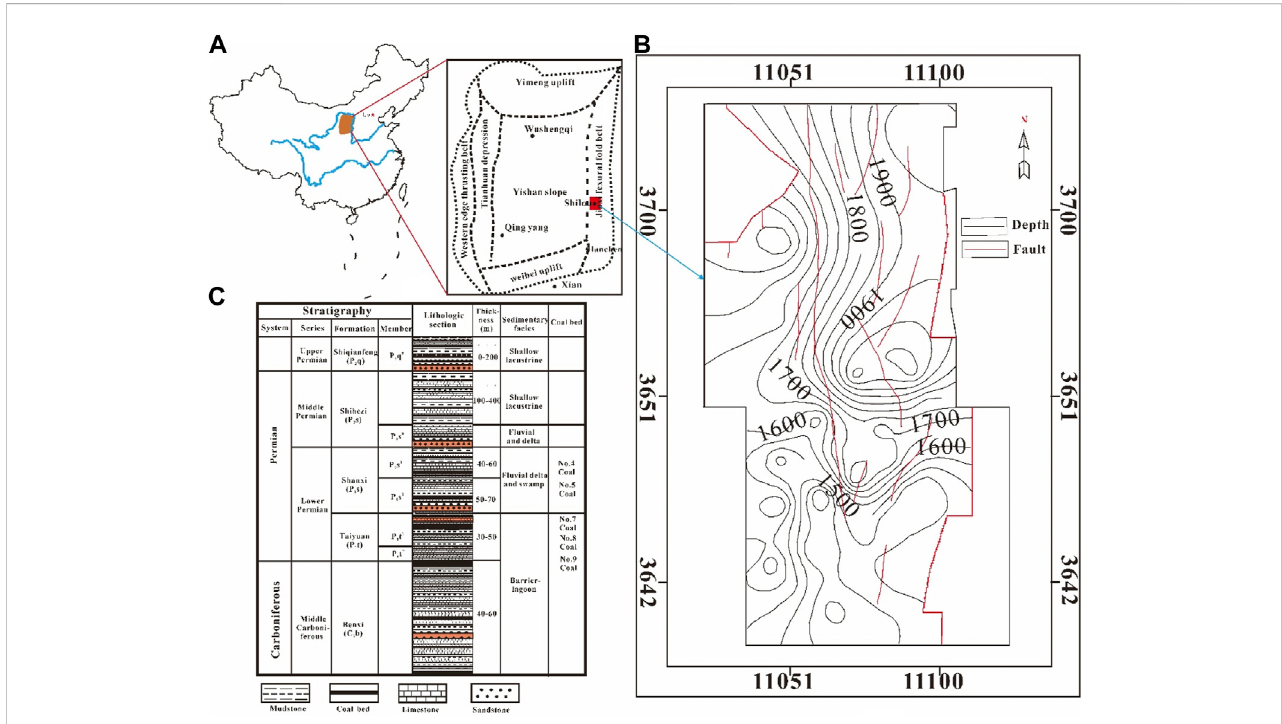
FIGURE 1 The location and geological setting of the SSN Block (revised from Tang et al., 2018), (A) and (B) are the geological structure map; (C) is the stratigraphic column.